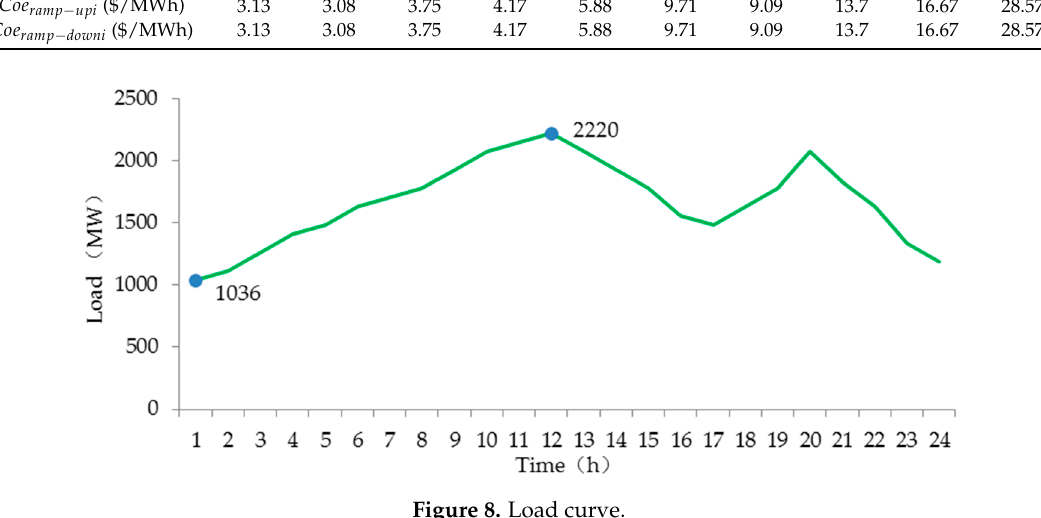
Figure 8. Load curve.